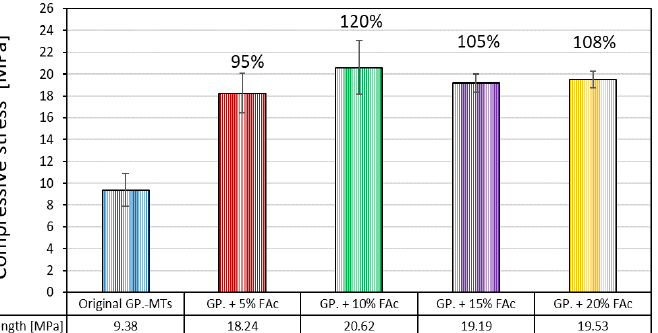
Figure 8. Comparative compressive strength of the original GP.-MTs with the co-geopolymerized systems at four different concentrations of systems at four different concentrations of FAc.